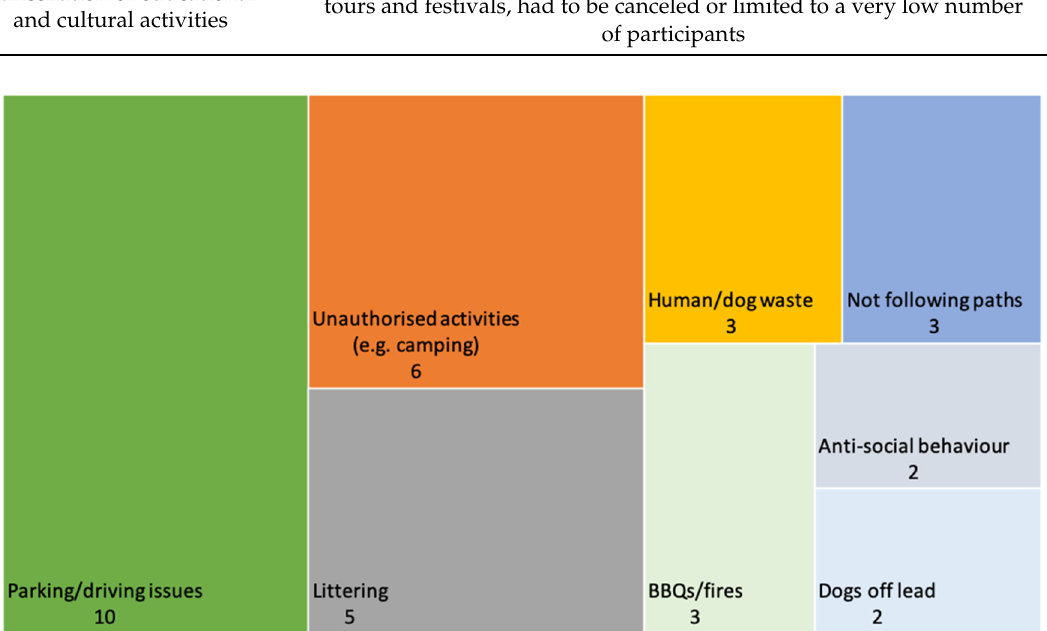
Figure 1. Frequency of problematic behavior during the first seven months of the pandemic mentioned by park authorities in the workshops. by park authorities in the